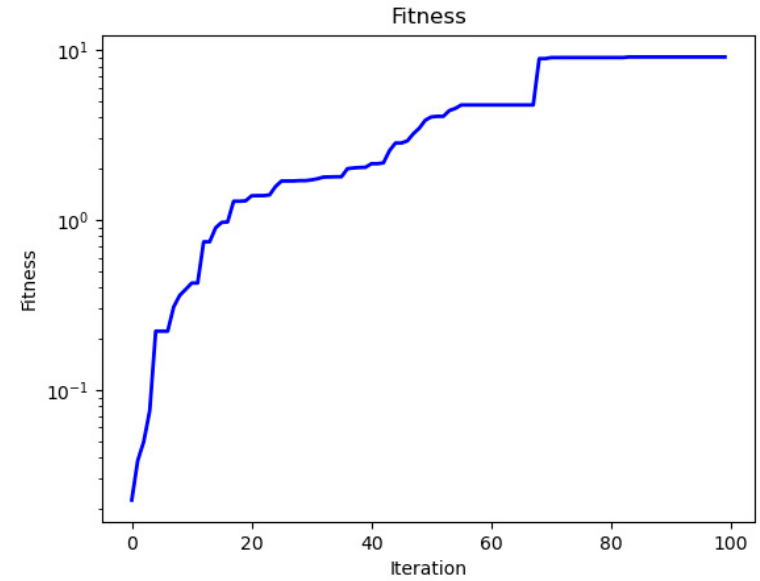
Figure 5. The iteration and corresponding fitness on dataset 1.